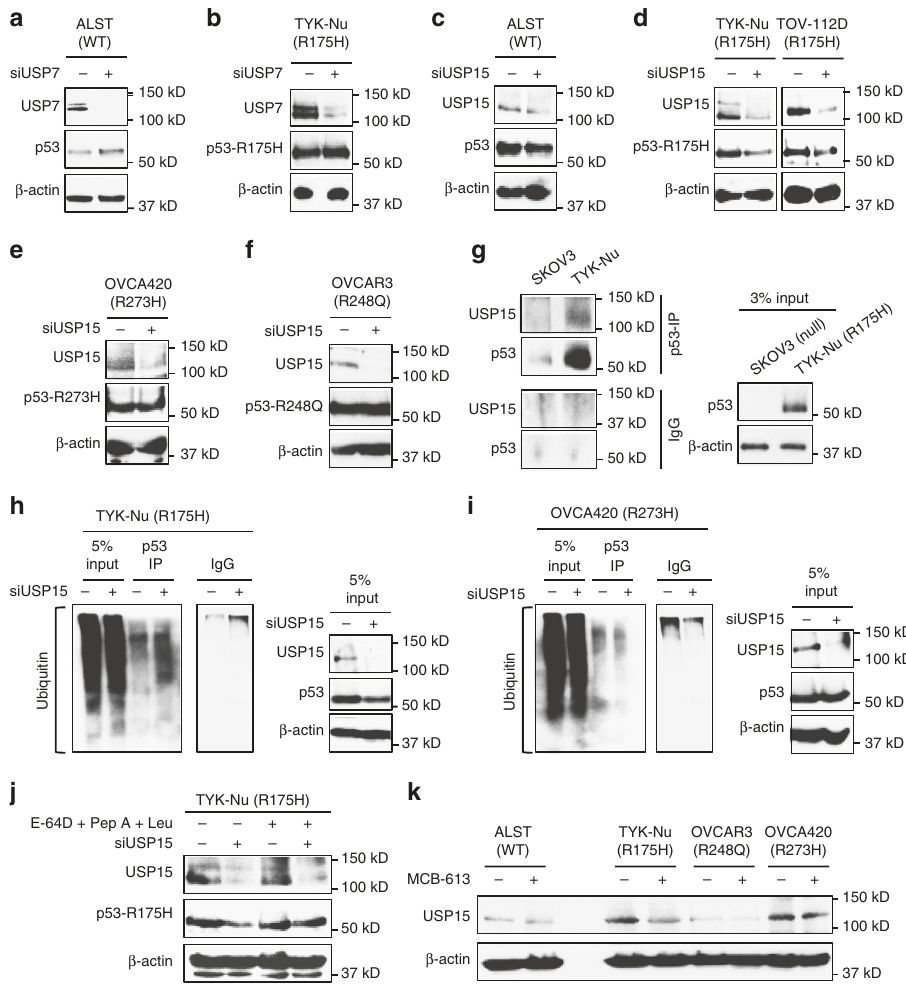
Fig. 6 USP15 regulates p53-R175H levels in ovarian cancer cells. a , b Effect of USP7 knockdown on a p53-WT and b p53-R175H levels. c , d USP15 knockdown causes c no effect on p53-WT levels (ALST cells) but d decrease in p53-R175H levels (TYK-Nu and TOV-112D cells). e , f siRNA-mediated knockdown of USP15 has no effect on the levels of e p53-R273H in OVCA420 cells and f p53-R248Q in OVCAR3 cells. g USP15 co-immunoprecipitates with p53-R175H. h Increased ubiquitination of p53-R175H upon USP15 knockdown. p53-R175H was immunoprecipitated from TYK-Nu cells treated with non-targeting siRNA and USP15 siRNA, using anti-p53 antibody (FL-393). Immunoblot for ubiquitin (anti-Ub (P4D1)) was performed on the immunoprecipitated proteins. i USP15 knockdown by siRNA does not result in increased ubiquitination of p53-R273H in OVCA420 cells. j Lysosomal inhibitors reversed the effect of USP15 siRNA on p53-R175H levels. k MCB-613 treatment (6 µ M, 2 h) results in decrease in USP15 protein